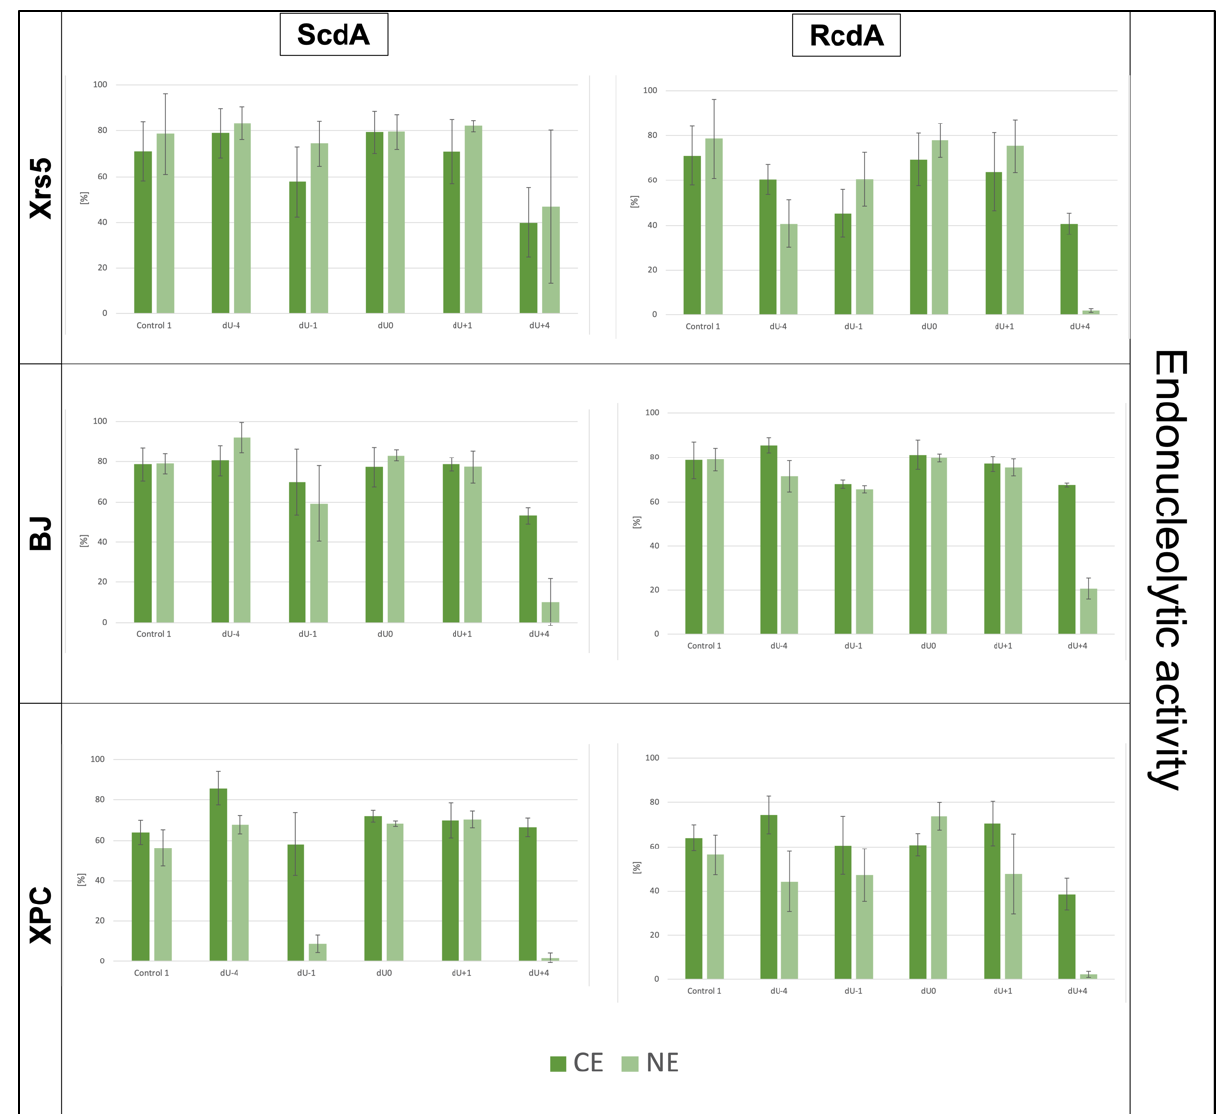
Figure 4. The endonucleolytic activity (observed after 1 min of reaction time) for oligonucleotides containing ds-CDL (shown in Figure 2 and Table S1) treated with cytoplasmic extracts (CE) obtained from three cell lines—xrs5, BJ, and XPC (raw numerical data is presented in Supplementary Materials in Tables S6–S11) and with nuclear extracts (NE) obtained from the same cell lines in previous studies [8,30].